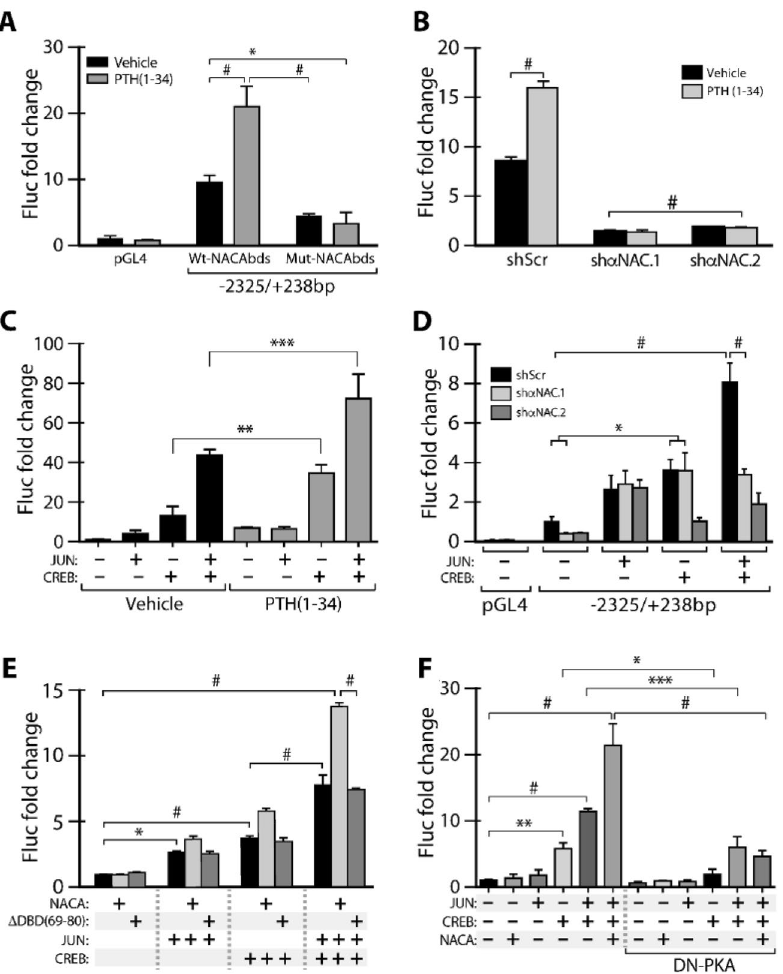
Figure 3. NACA, JUN, and CREB are implicated in Usp53 promoter regulation. ( A ) Firefly luciferase (Fluc) reporter assay was performed using MC3T3-E1 cells overexpressing wildtype or mutated Usp53 -Luc vector (-2325/+ 238 bp). The mutated region lies in the proximal NACA binding site of the Usp53 -Luc vector. ( B ) Firefly luciferase (Fluc) reporter assay were performed using MC3T3-E1 cells stably expressing shRNAs targeting Naca (shαNAC.1 and shαNAC.2) or scrambled shRNA (shScr) as a control by lentiviral infection. When indicated, cells were treated with vehicle or 100 nM PTH (1–34) for 24 h before performing the assay. ( C ) Firefly luciferase (Fluc) reporter assay in MC3T3-E1 cells transfected with Usp53 -Luc vector (− 2325/+ 238 bp) alone or along with JUN and/or CREB expression vectors treated with vehicle or 100 nM PTH(1–34) for 24 h. ( D ) Firefly luciferase (Fluc) reporter assay in MC3T3-E1 cells stably expressing shRNAs against Naca (shNACA.1 and shNACA.2) or scrambled shRNA (shScr), transfected with Usp53 -Luc vector (-2325/+ 238 bp) alone or along with JUN and/or CREB expression vectors. Cells were treated with 100 nM PTH (1–34) for 24 h before performing the assay. ( E ) Firefly luciferase (Fluc) reporter assay in MC3T3-E1 cells transfected with Usp53 -Luc vector (-2325/+ 238 bp) alone or along with NACA-S99D or NACA mutant deltaDBD (69–80), JUN and/or CREB expression vectors. Cells were treated with 100 nM PTH (1–34) for 24 h before performing the assay. ( F ) Firefly luciferase (Fluc) reporter assay in MC3T3-E1 cells transfected with Usp53 -Luc vector (-2325/+ 238 bp) alone or along with 50 ng of NACA, JUN and/or CREB expression vectors, with or without 100 ng of dominant negative DN-PKA expression vector. Cells were treated with 100 nM PTH(1–34) for 24 h before performing the assay. Empty pGL4 vector was used as a negative control. Firefly luciferase counts were normalized to Renilla counts. Results are presented as the mean fold induction ± SD. * P ≤ 0.05; ** P ≤ 0.01; *** P ≤ 0.001; # P < 0.0001; ANOVA with Bonferroni’s post-hoc test for all